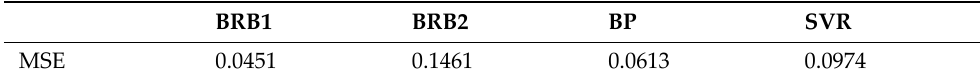
Table 16. Comparison of test results of various methods. BRB1